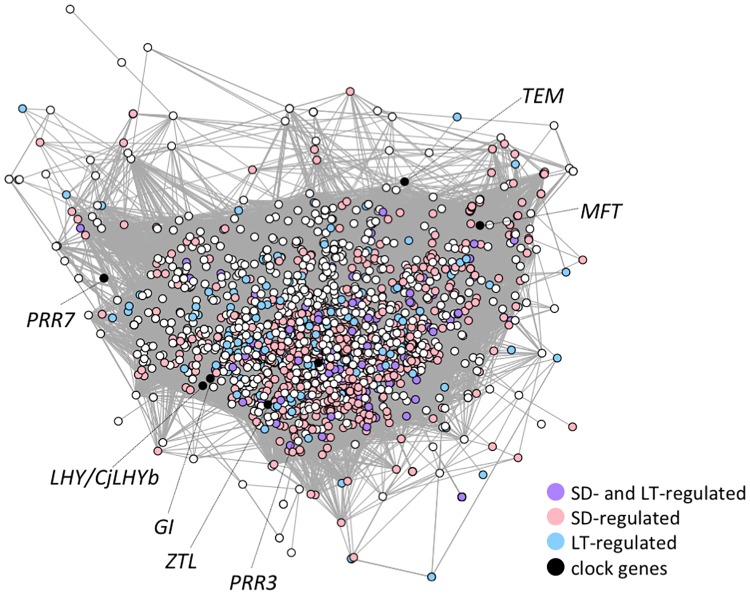
Co-expression gene network of annual transcriptome dynamics.The gene network was estimated based on correlation coefficients of the expression value between genes using the microarray data of annual time series samples, and 1,953 targets were connected. Dot colors indicate the results of experimental time series samples; “SD-regulated” indicates targets that were up- or down-regulated under SD conditions, “LT-regulated” indicates targets that were up- or down-regulated under LT conditions, and “SD- and LT-regulated” indicates targets that were up- or down-regulated under both SD and LT conditions. This result demonstrated a close relationship between SD- and LT-regulated genes in the annual transcriptome dynamics.